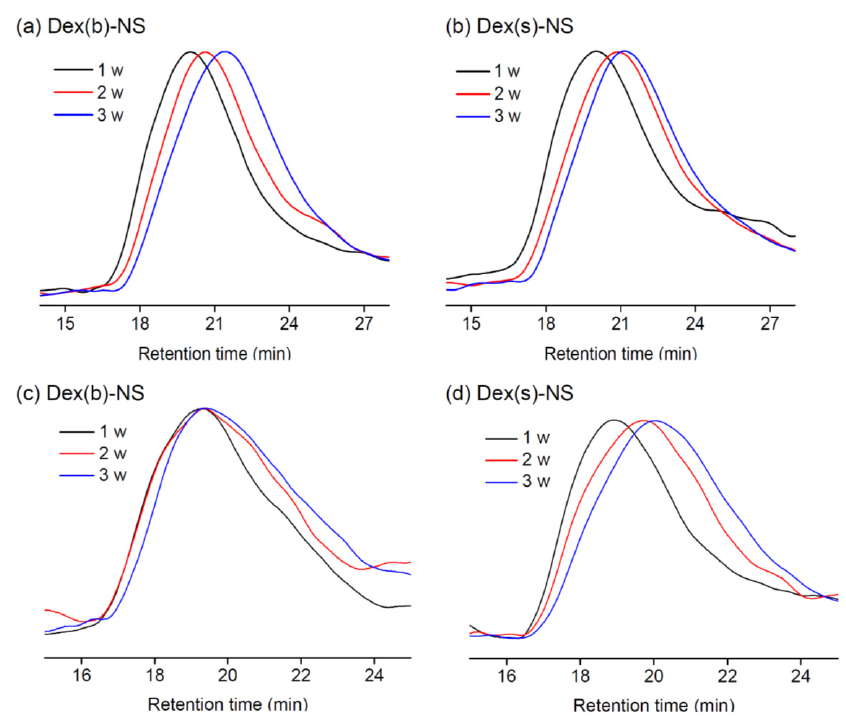
Figure 5. Gel permeation chromatograph (GPC) charts to analyze ( a , b ) in vitro ; and ( c , d ) in vivo degradation of ( a , c ) Dex(b)-NS; and ( b , d ) Dex(s)-NS for 1–3 weeks.